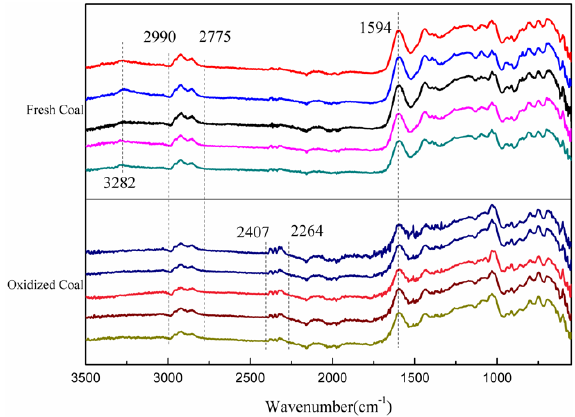
Figure 4. Comparison of infrared experiment results of fresh coal and oxidized coal.